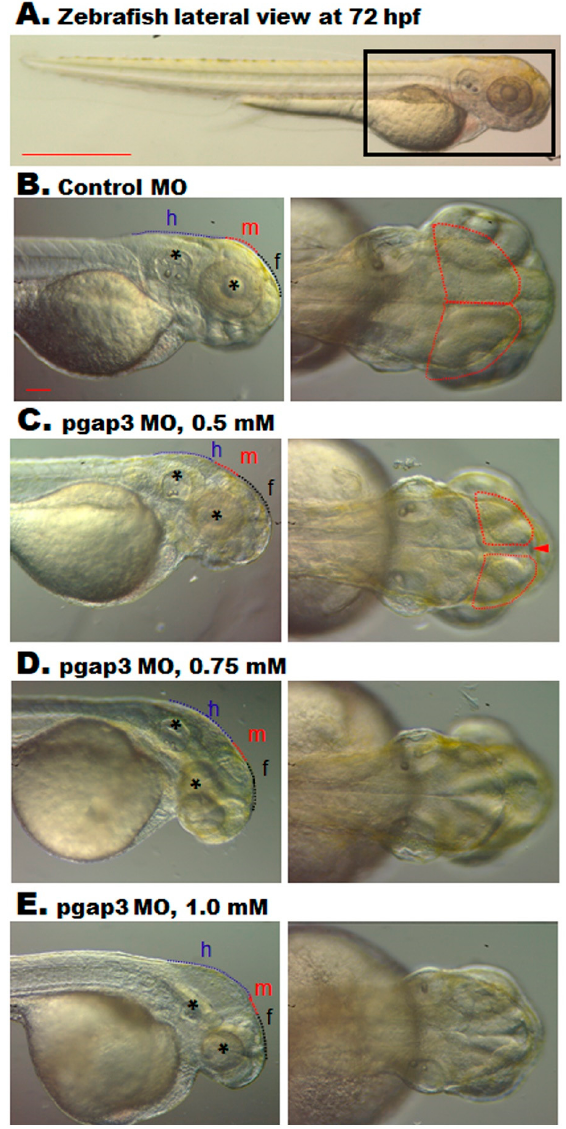
Figure 4. Knockdown of Pgap3 resulted in zebrafish developmental deformities. ( A ) Control zebrafish full-body positioned at the lateral view at 72 h post-fertilization (hpf), black box zooming on the zebrafish head at a magnification of 32 × , scale bar 100 µ m. ( B ) Gross examination of the control group at a lateral and dorsal view of the zebrafish head showing normal brain development, normal forebrain, midbrain that typically expanded to the left and right tectal ventricles and hindbrain. Normal head orientation demonstrated by a black asterisk indicating the position of the ear and eye. ( C – E ) The knockdown of Pgap3 resulted in developmental brain deformities. Examined zebrafish pagp3 morphants showed brain defects and dysmorphic facial features that demonstrate a dose-dependent severity. Zebrafish pgap3 morphants displayed a delay in brain development, separation (red arrowhead) between the left and right ventricles of the midbrain (( C ) traced by dotted red shape), and reduction in head size relative to control and low sets of ears in comparison to eye position (black asterisks). Dotted black, red, and blue lines illustrate the forebrain (f), midbrain (m), and hindbrain (h) structures, respectively. Experiments performed three times, and the total number of embryos examined: 30, 40, 45, 35 for control MO, pgap3 MO 0.5, 0.75, 1.0 mM, respectively. Zebrafish imaging using Zeiss Lumar 12 stereomicroscope with a ZEISS camera (Model Axiocam Erc 5s) at a magnification of 100 × for head images, scale bar 10 µ